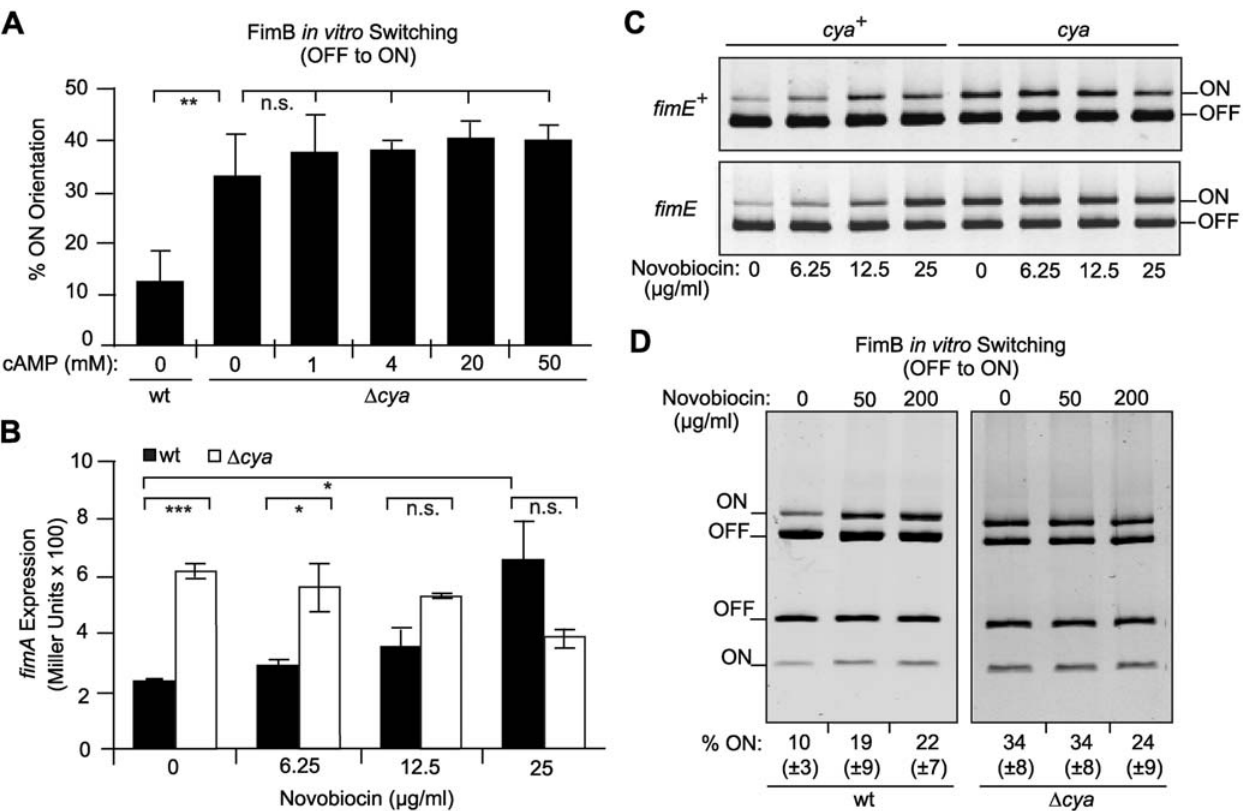
Figure 5. Insights on the mechanism of action of the CRP-cAMP complex invivo and invitro . (A) Effect of the addition of cAMP during in vitro OFF to ON recombination. Bacterial extracts were obtained from strains NEC026 (wt) or CMM026 ( D cya ) transformed with the inducible fimB expression plasmid (pIB378). Extracts were mixed with the template plasmid pJL-2 in absence or presence of increasing amounts of cAMP (1 to 50 mM final concentration). Mean values and standard deviations of three independent experiments are shown. (B) Effect of increasing amounts of the gyrase inhibitor novobiocin on fimA expression. ß-galactosidase activity was measured from strains CBP198 (wt, black bars) and CMM198 ( D c ya , white bars) grown to mid-log phase in LB medium supplemented with 0, 6.25, 12.5, and 25 m g ml 2 1 novobiocin. Mean values and standard deviations from two independent experiments are shown. (C) Effect of DNA gyrase inhibition on the orientation of the fim invertible element in vivo . Upper panel: ON-OFF diagnostic of the samples used in Fig. 5B, representing the strain CBP198 ( fimB + fimE + ) and its cya derivative CMM198 grown in presence of novobiocin (concentrations as indicated). Lower panel: ON-OFF diagnostic of the strain AAEC370A ( fimB + fimE ) and its D cya derivative CMM370A subject to the same growth conditions as in the upper panel. Both panels depict electronically inverted images of the upper half of acrylamide gels after ethidium bromide staining. (D) Effect of DNA gyrase inhibition on FimB-mediated OFF to ON switching in vitro . Increasing amounts of novobiocin (0, 50, 200 m g ml 2 1 ) were added to the in vitro recombination reactions. Bacterial extracts from strains NEC026 (wt, left panel) or CMM026 ( D cya , right panel) transformed with the inducible fimB expression plasmid (pIB378) were used together with the template plasmid pJL-2. Mean values and standard deviations in brackets of the estimated percentage of invertible elements in the ON orientation from four independent experiments are given as numbers below each lane. The images correspond to ethidium bromide stained gels from a representative experiment used to obtain the data